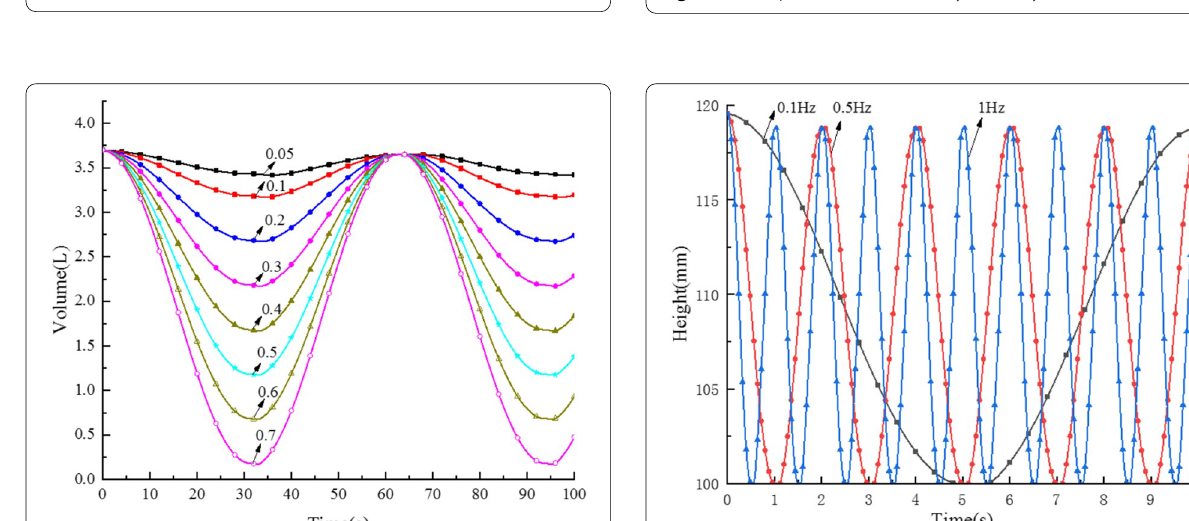
Figure 14 Changes in height at different ratios